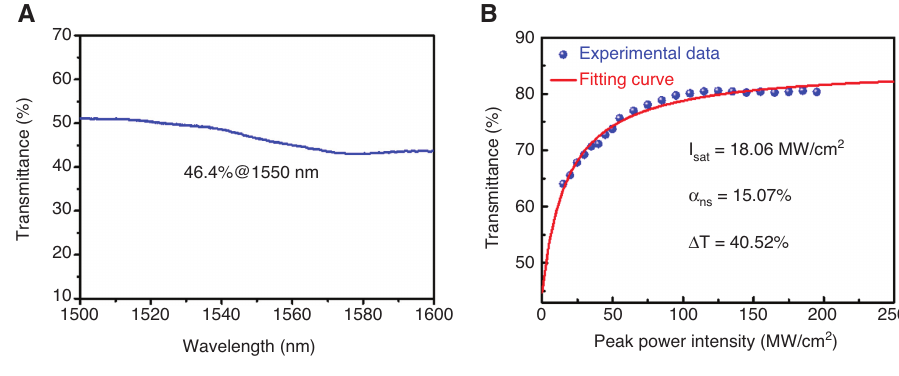
SA. 2 SA; (B) the nonlinear optical absorption curve of the microfiber-VS 2